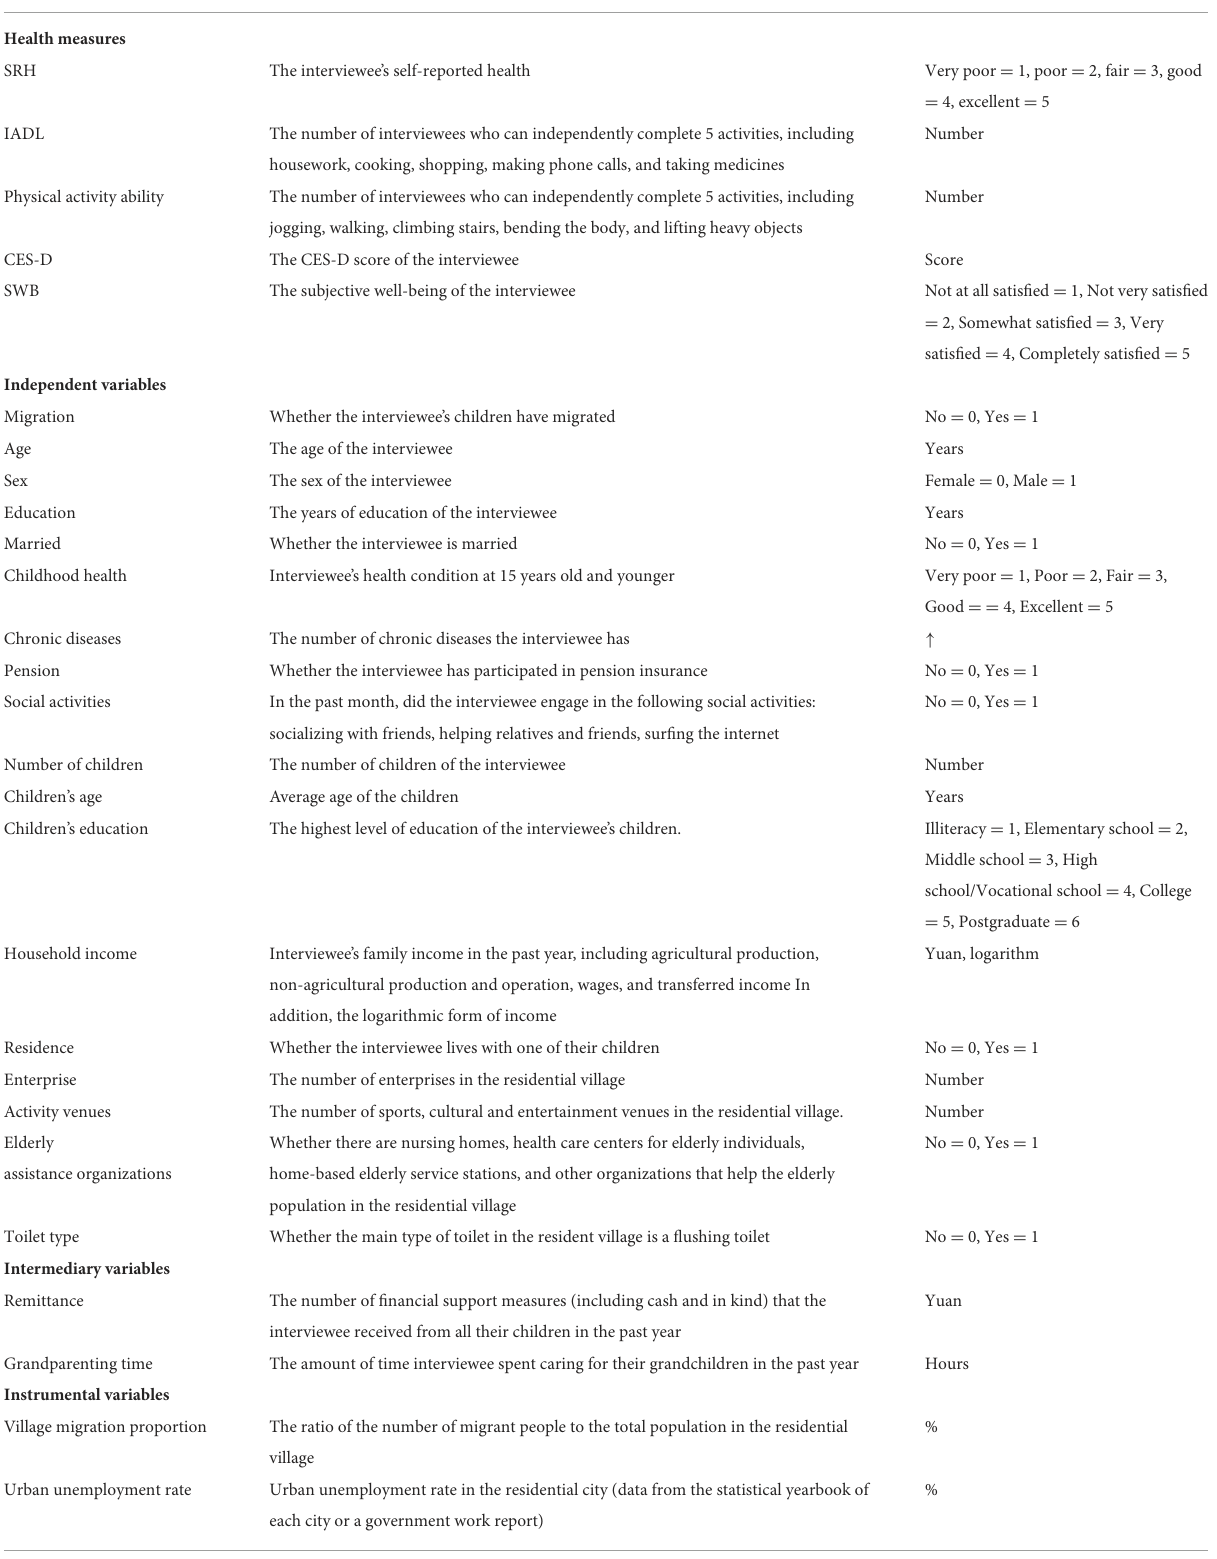
TABLE 1 Measurement of main